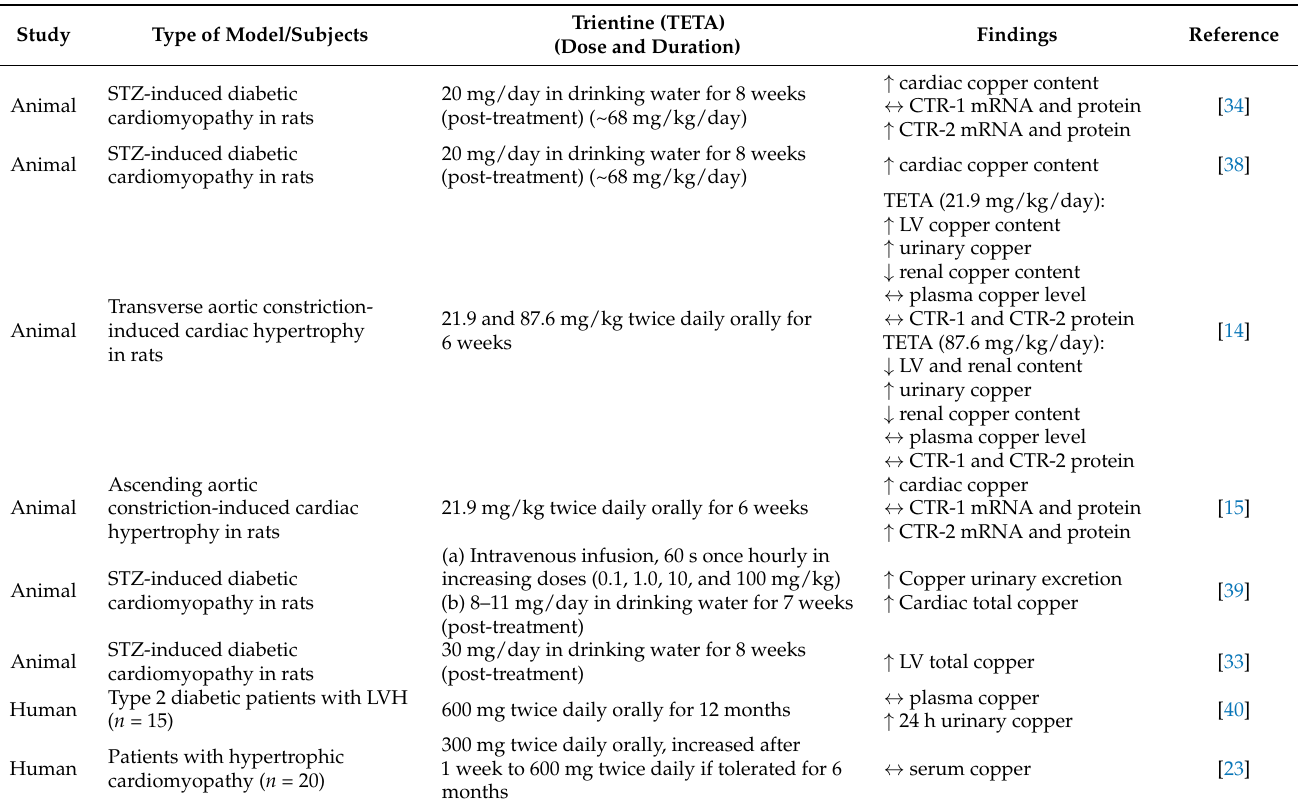
Table 1. The effects of trientine on cardiac copper regulation in animals and related blood parameters in animals and patients with